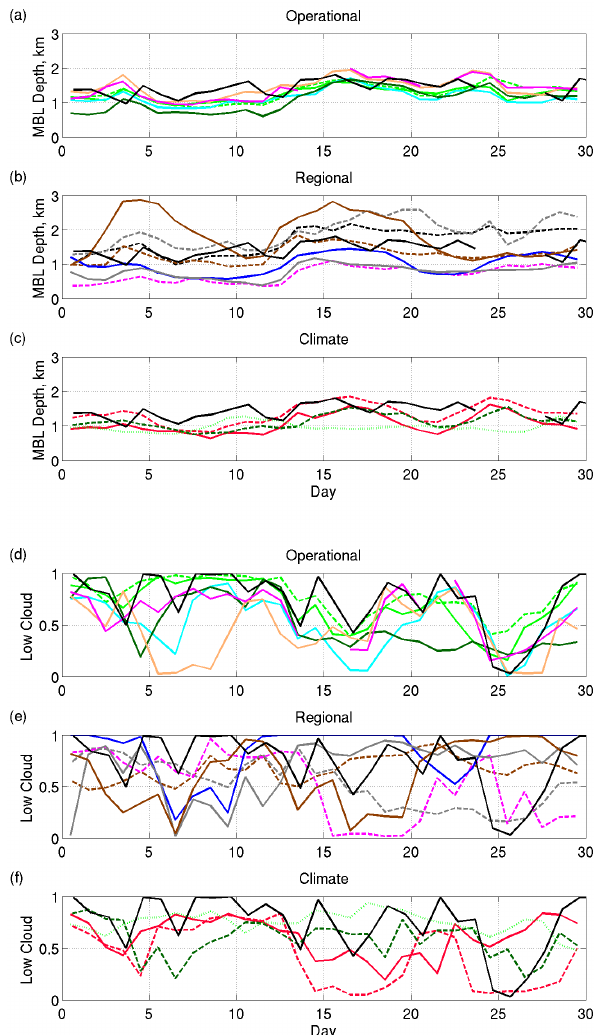
Fig. 15. October 2006 time series of 24-h mean boundary layer depth in km (a–c) and low cloud fraction (d–f) for a 3 ◦ × 3 ◦ box centered at 20 ◦ S 85 ◦ W. Solid black lines are MODIS cloud-top height and MODIS cloud fraction. Model line types as in Fig. 8.